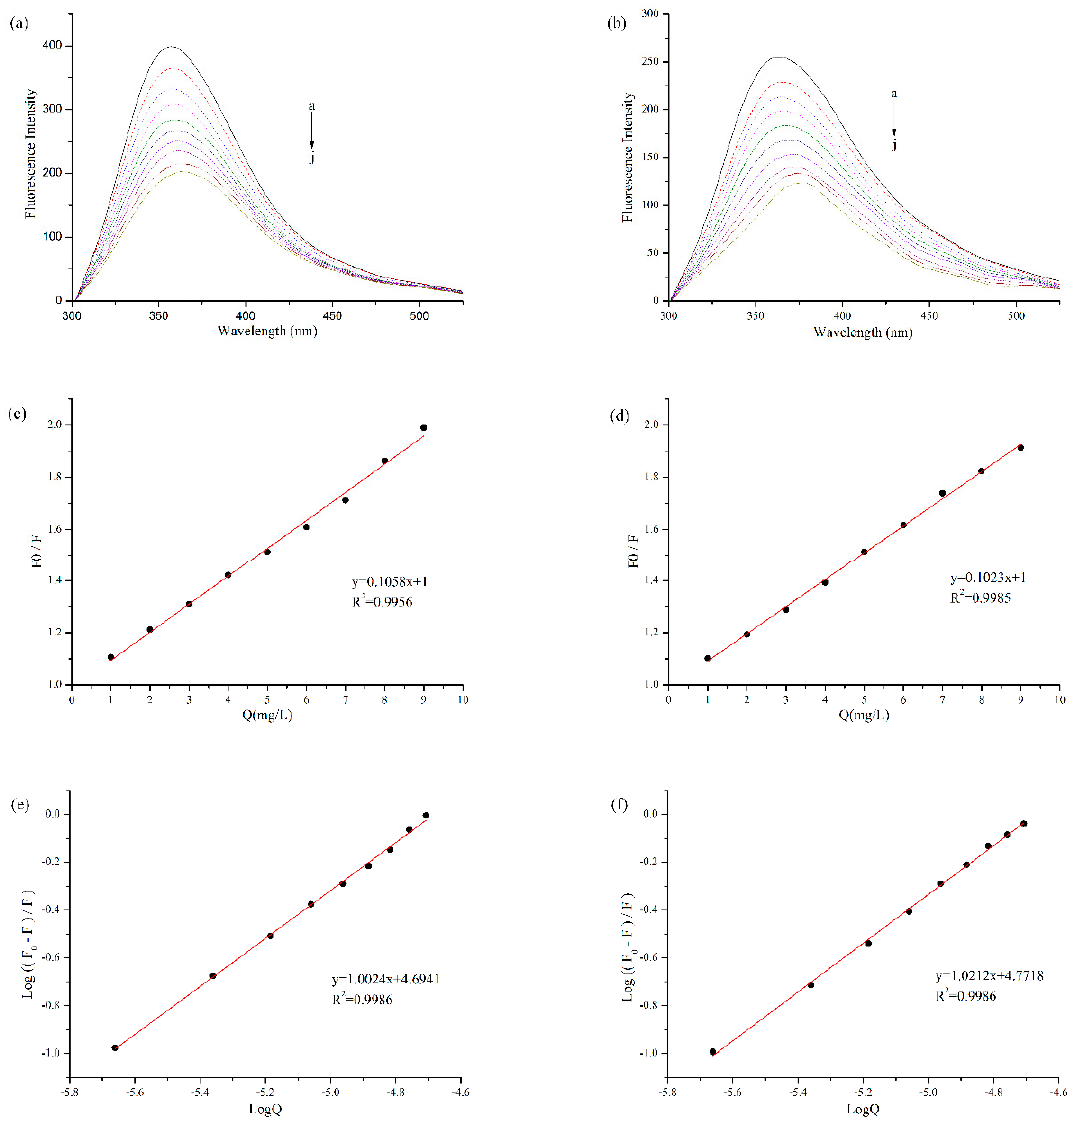
Figure 2. Fluorescence quenching analysis of BBPI ( a ) and BBPI-G ( b ) treated with di ff erent concentrations of EGCG (a–j: 0, 1, 2, 3, 4, 5, 6, 7, 8, and 9 mg / L) at pH 7.0. The Stern-Volmer plots to determine K sv of BBPI ( c ) and BBPI-G ( d ). The Double logarithm plot to determine K a and n of BBPI ( e ) and BBPI-G ( f ).